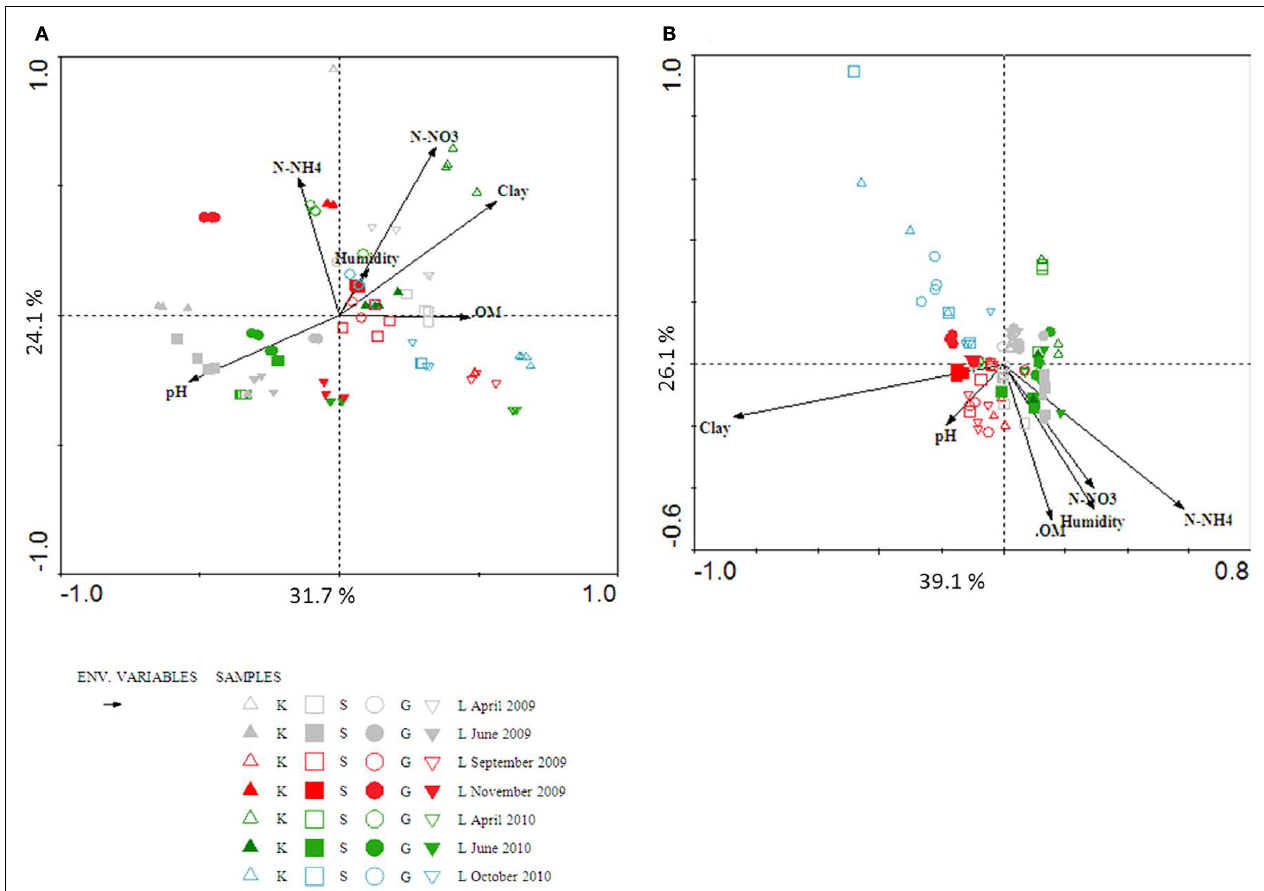
soil moisture (Humidity), soil nitrate (N-NO 3 ), soil ammonium (N-NH 4 ), organic matter (OM), clay content (clay), soil pH (pH) are presented with black